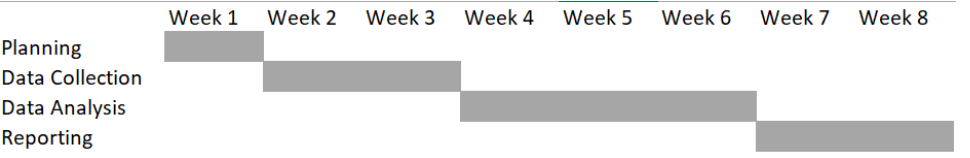
Figure 14. Comparison and discussion